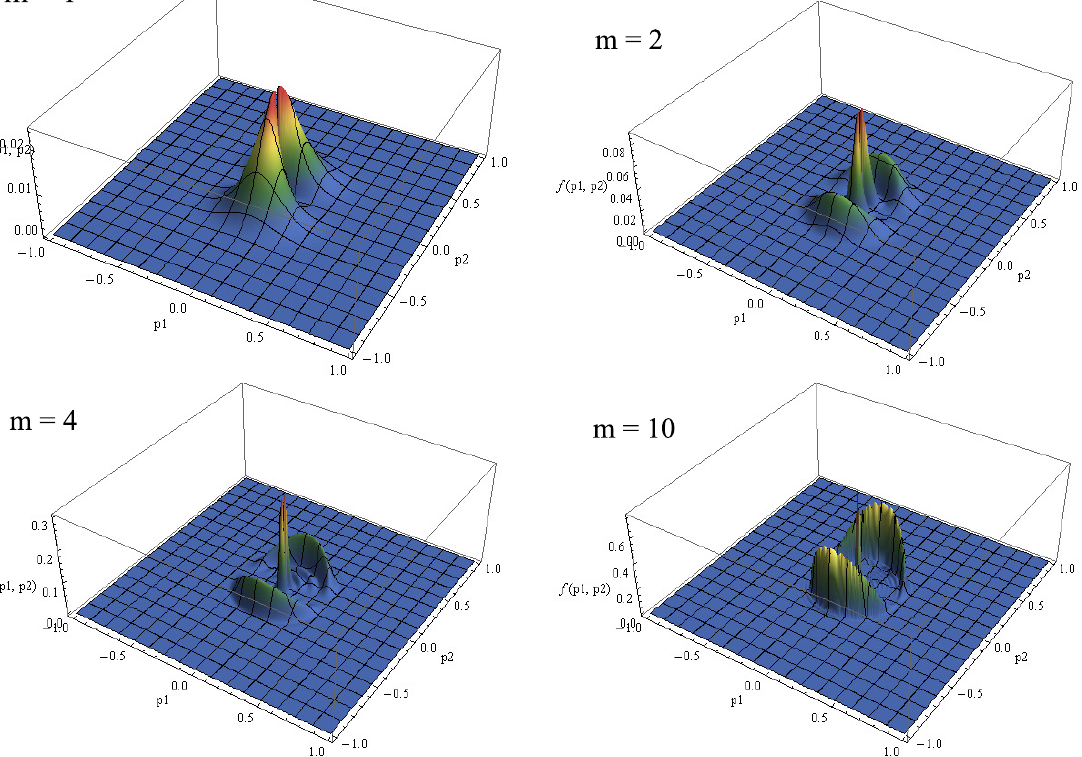
Figure 6. The stages of evolution of the distribution function under the action of the field of type (59) with the number of periods m = 1,2,4 and 10,